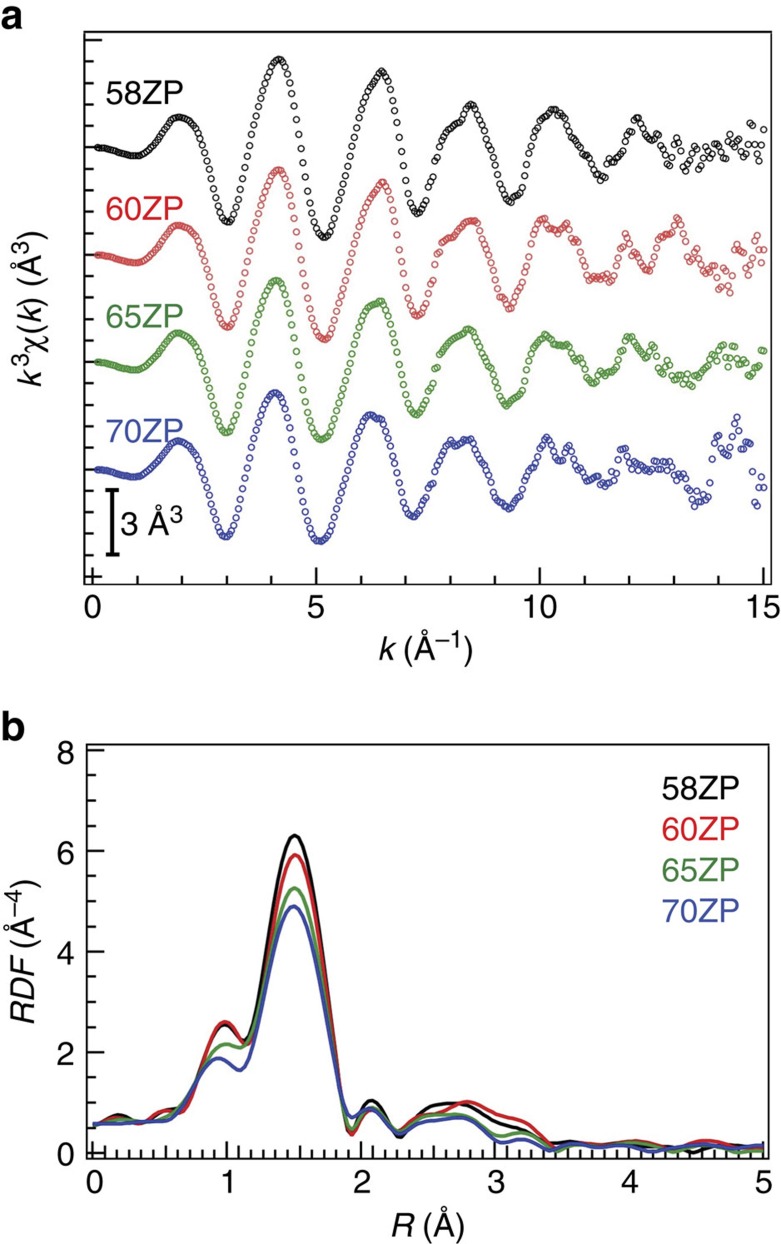
EXAFS analysis of the ZP glass.(a) EXAFS spectra k3χ(k) of the ZnO–P2O5 glass and (b) |FT(R)| of the spectra.